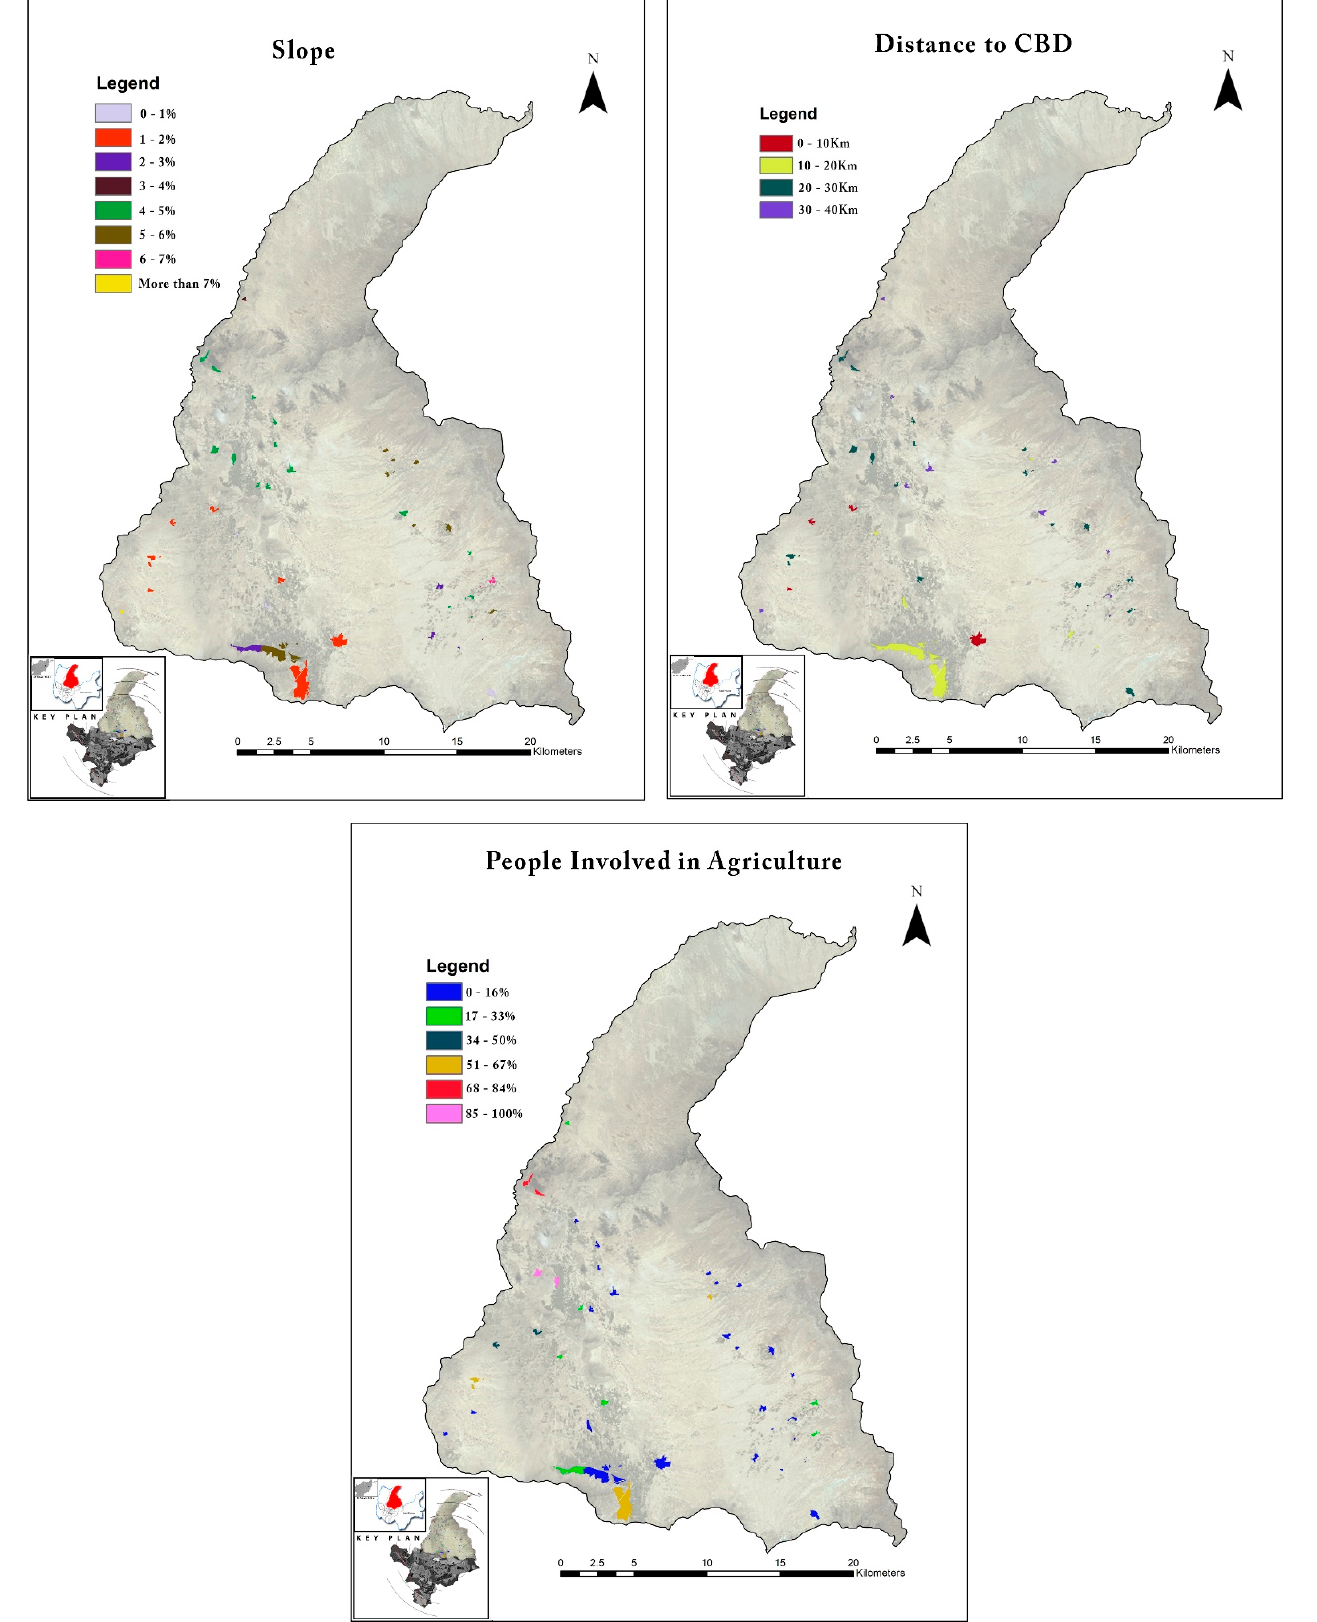
Figure 12. Parameters with their sub-indexes.